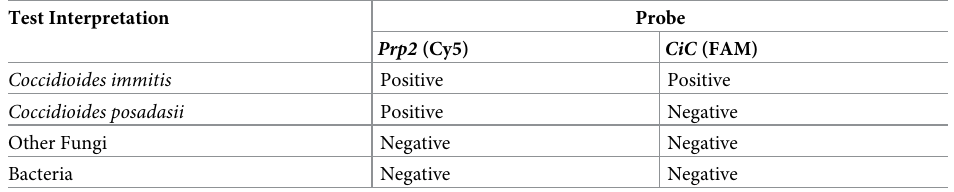
Table 3. Test interpretation of Coccidioides duplex real-time PCR assay.